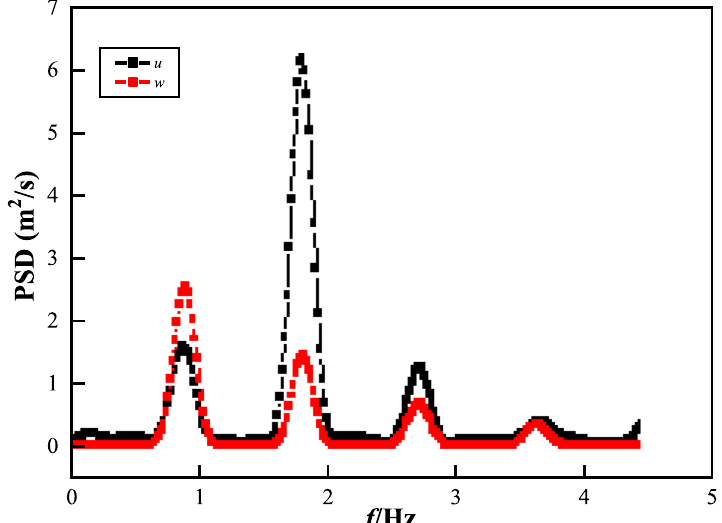
Fig. 8 Measured Fourier transform amplitude spectrum during the pulsating wind time interval (Han,